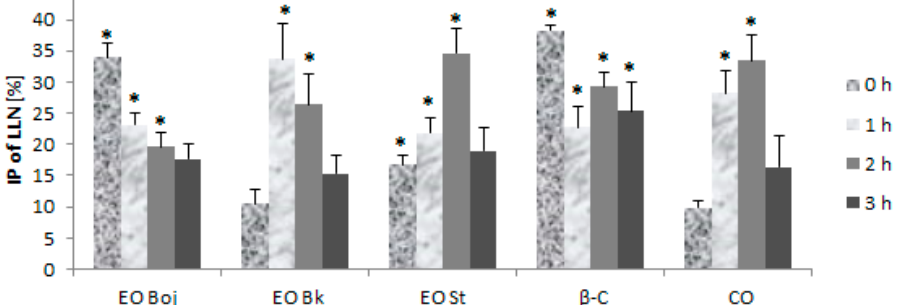
Figure 3. Inhibition percentage (IP) of local lesion number (LLN) on the half ‐ leaves of Chenopodium quinoa plants inoculated with Cucumber mosaic virus containing associated satellite RNA (CMVsat). Prior to inoculation, the virus was incubated for a short time (0 h), 1 h, 2 h or 3 h with essential oil (EO) of Micromeria croatica from the localities Bojinac (Boj), Ba č i ć kuk (Bk) and Stupa č inovo (St), β‐ caryophyllene ( β‐ C) and caryophyllene oxide (CO). Control half ‐ leaves were inoculated with virus inocula without EO or oil components. Ten to fifteen experimental plants (four leaves per plant) were inoculated in each group. Values are expressed as the mean value + SD calculated based on the three independent evaluations (n = 3). The asterisk (*) denotes significant inhibition of LLN compared to the control ( p < 0.05).